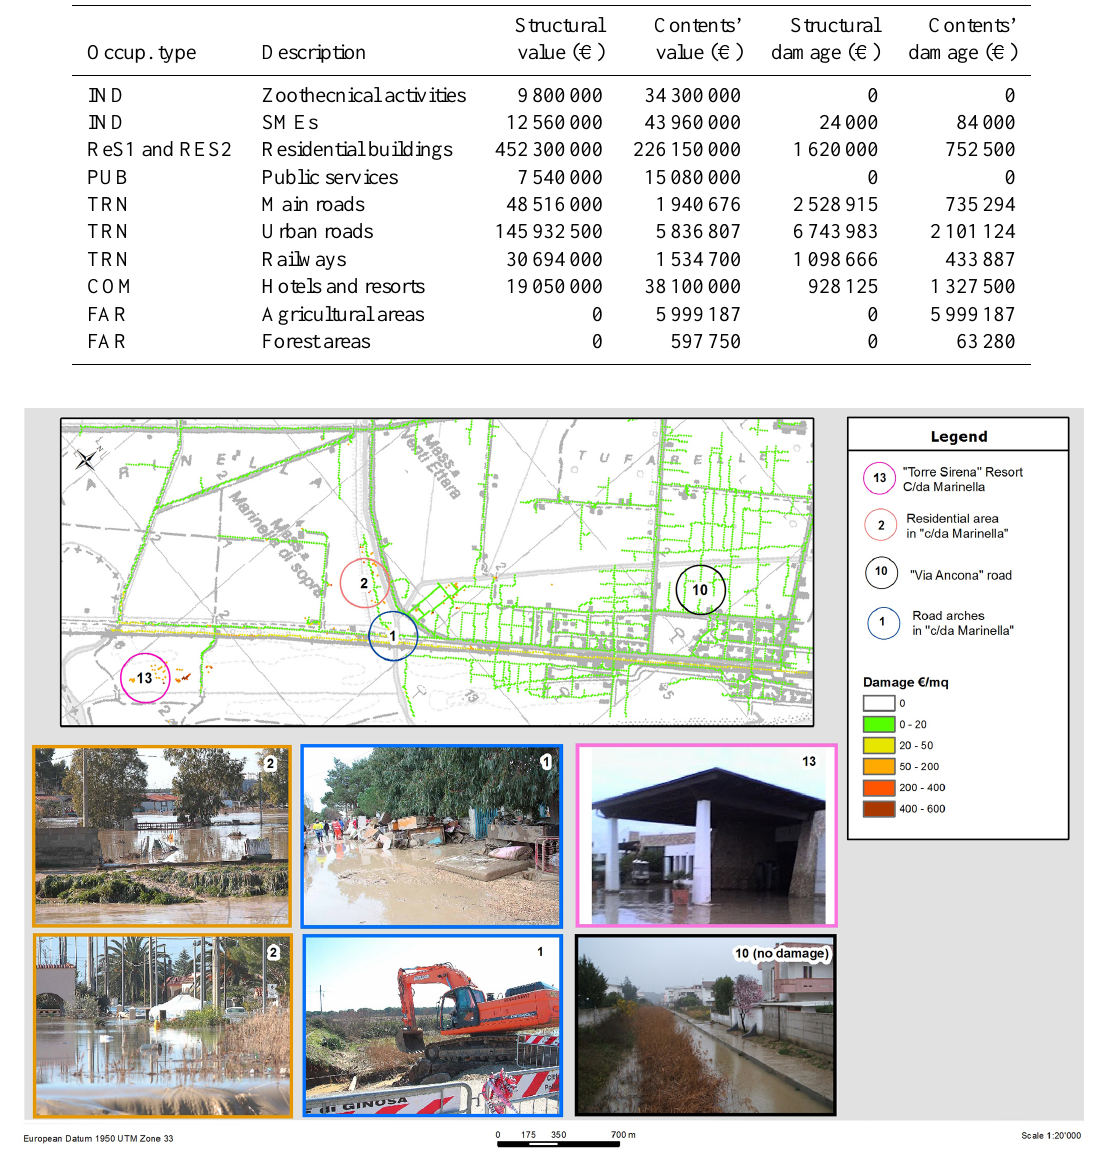
Table 5. Direct economic damage due to the event simulated by the model.